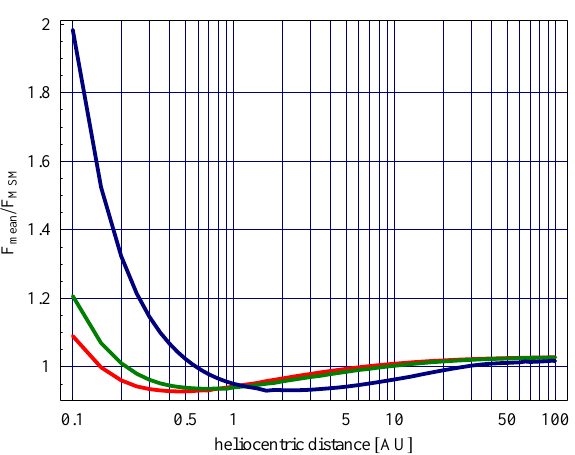
Fig. 14. Deviations of He + pickup flux from the solar-cycle mean for the downwind axis at several heliocentric distances, indicated in the inset box. For reference, deviations of the ionization rate from the mean value β (t)/β mean are shown, as indicated in the